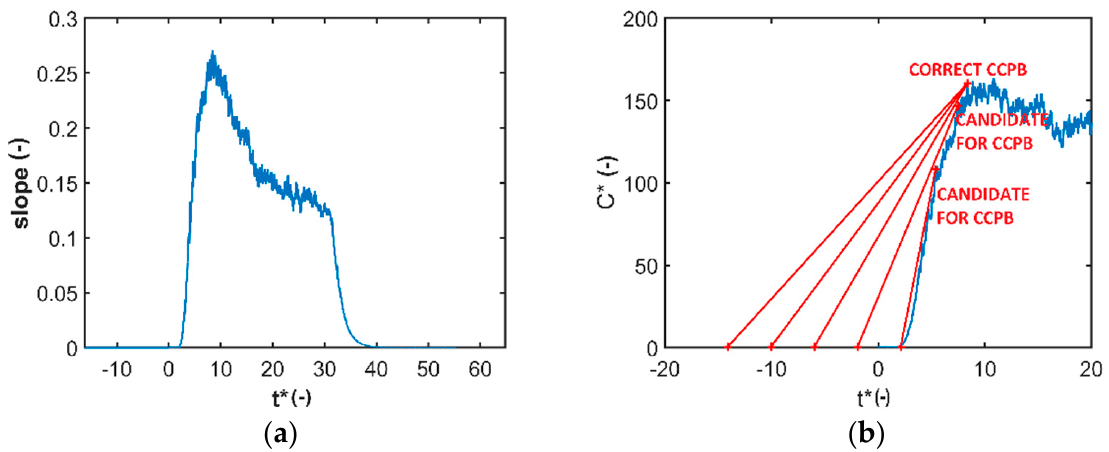
Figure 4. Finding the beginning of CCP (CCPB): ( a ) slopes of segment lines; ( b ) finding the correct CCPB.